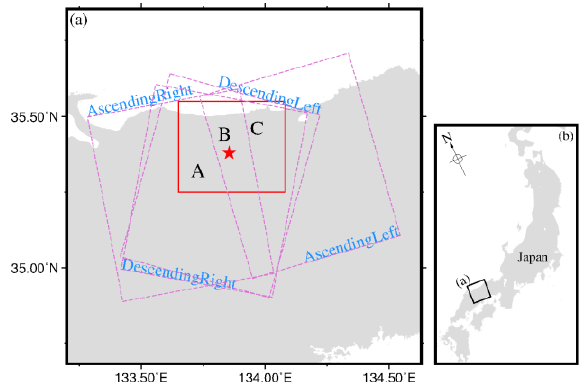
Figure 1. Footprints of the used ALOS-2 PALSAR-2 data. In (a), the red box indicates the limit of study area, the dashed orchid boxes outline the footprints of each interferogram and the red star represents the epicenter of this earthquake. (b) shows the location of the study area relative to Japan The final geocoded deformation maps in the LOS direction